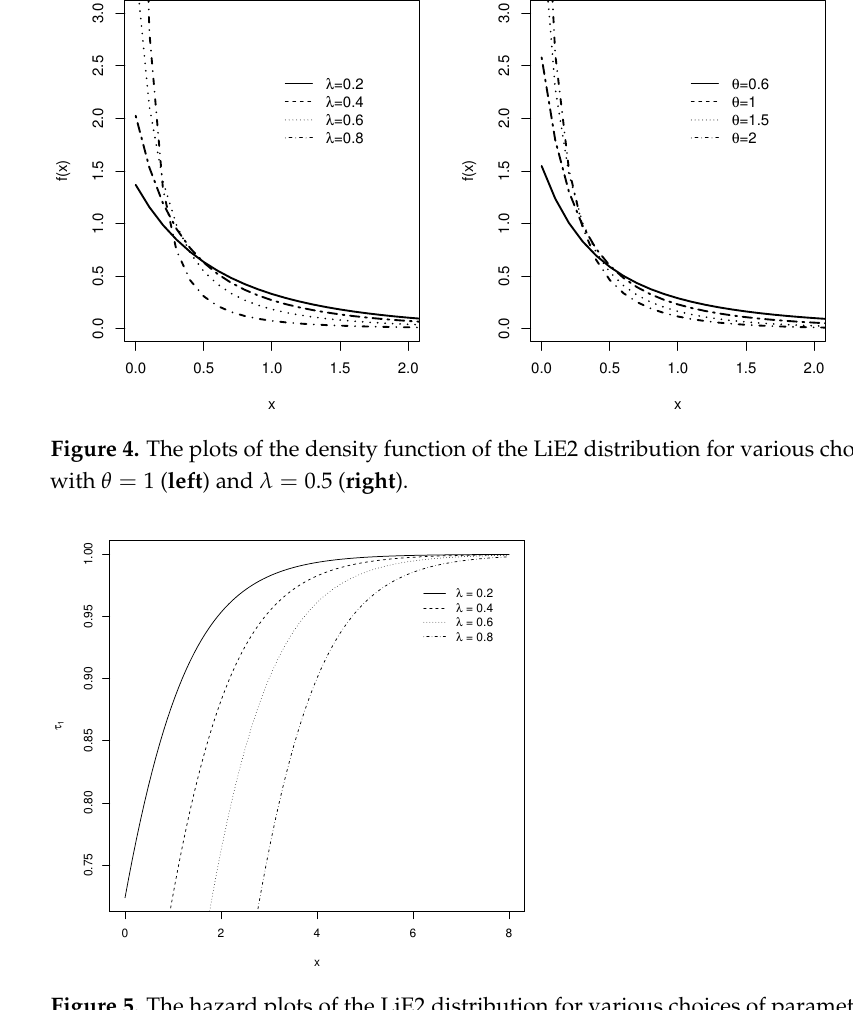
Figure 5. The hazard plots of the LiE2 distribution for various choices of parameter λ with θ =